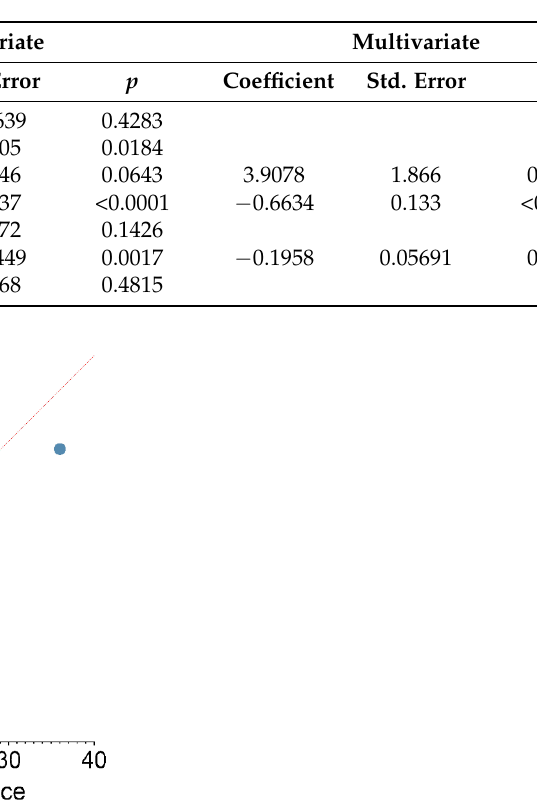
Table 3. Prediction of left ventricle improvement after upgrade procedure in patients with pacing- induced cardiomyopathy.